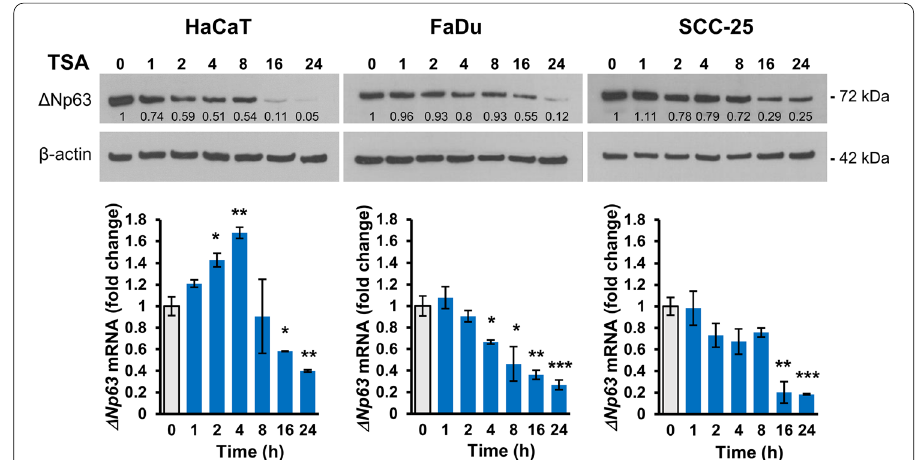
Fig. 6 Time course of ΔNp63 response to trichostatin A Top panels; Representative western blots of ΔNp63 (72 kDa) and β-actin (42 kDa) as loading control for HaCaT, FaDu and SCC-25 cells treated with 1 µM trichostatin A (TSA) for the indicated times. Relative ΔNp63 densitometry measurements normalized to β-actin are indicated, with 0 used as control. Lower panels; RT-qPCR for ΔNp63 mRNA shown as fold change in treated cells relative to untreated cells after normalization to ACTB mRNA. *p < 0.05; **p < 0.01; ***p < 0.001 compared to untreated control